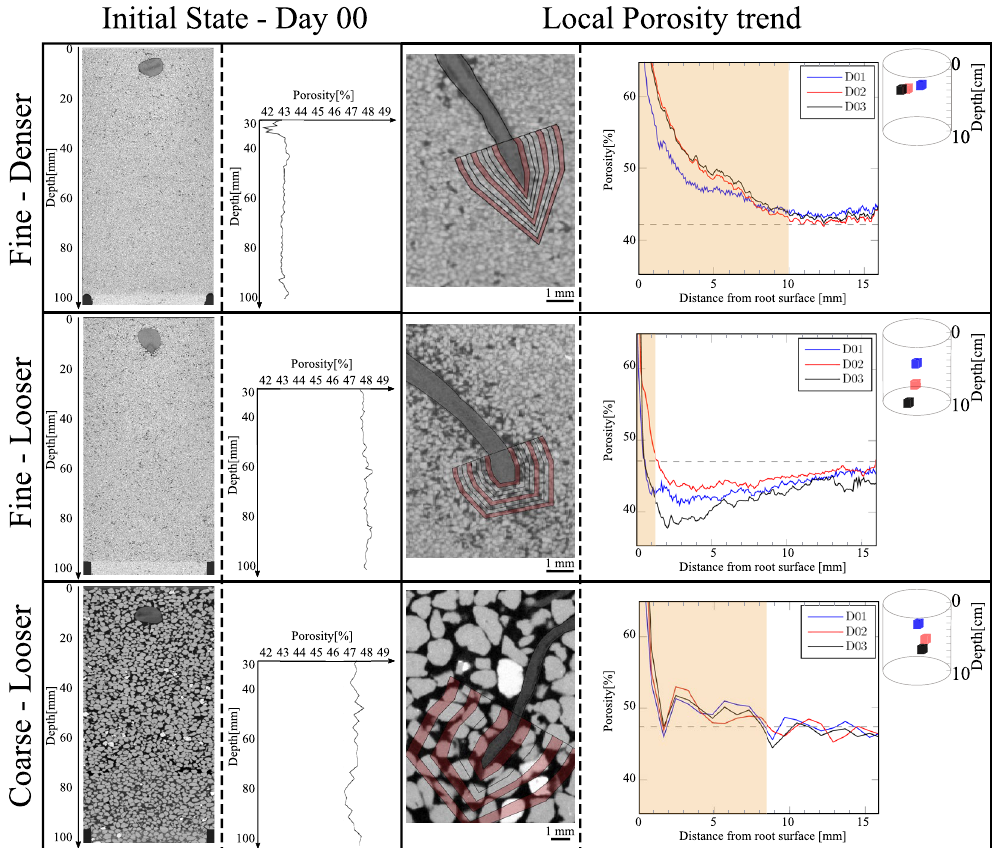
Figure 5. Vertical cross section of the greyscale image and vertical profile of sand bulk porosity at the initial state, Day 0 (left); change of the bulk porosity of sand with the distance from the surface of the primary root (the yellow area represents the distance range where the porosity is higher than the initial global one): for a given distance the porosity is computed within a hollow volume such as one of the red volumes drawn on the greyscale image around the root tip (center). The position of the small volume of soil used for the analysis is shown in the top right corner of each